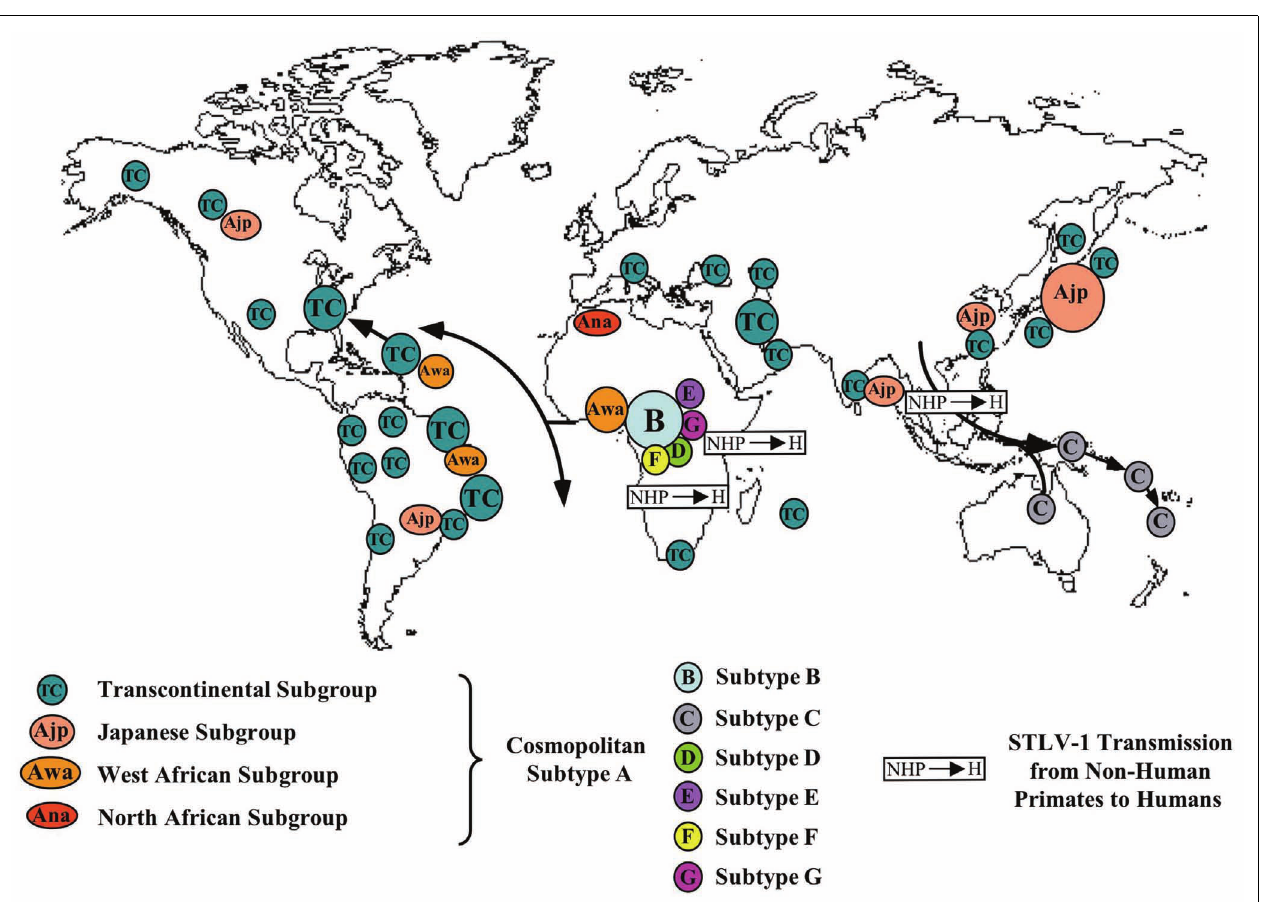
being the most frequent in this large endemic area, C or Australo- Melanesian D, also from Central Africa and present especially in certain Pygmy groups and lastly E, F, G with very few strains yet reported (all in Central Africa).The main HTLV-1 molecular epidemiological studies used to draw this map are the following ones: (Gessain et al., 1991; Gasmi et al., 1994; Miura et al., 1994; Mahieux et al., 1997, 1998; Salemi et al., 1998; Vandamme et al., 1998;Wolfe et al., 2005; Cassar et al., 2007; Gessain,